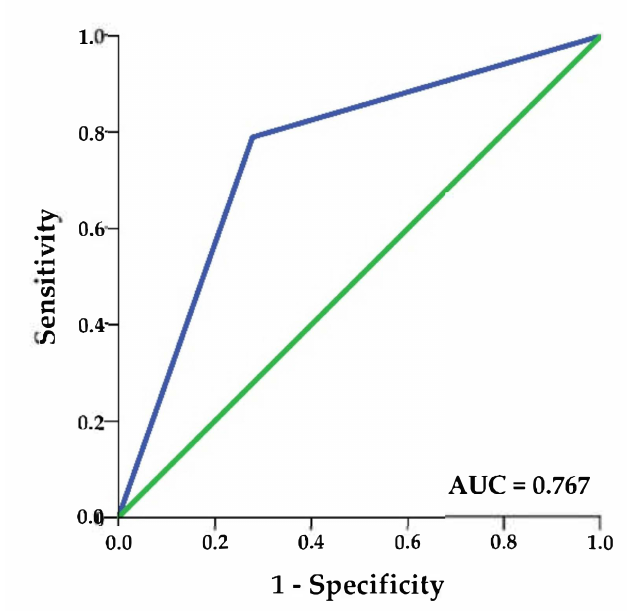
Figure 4. Receiver operator characteristic curve for KIT protein expression. AUC, area under the curve.